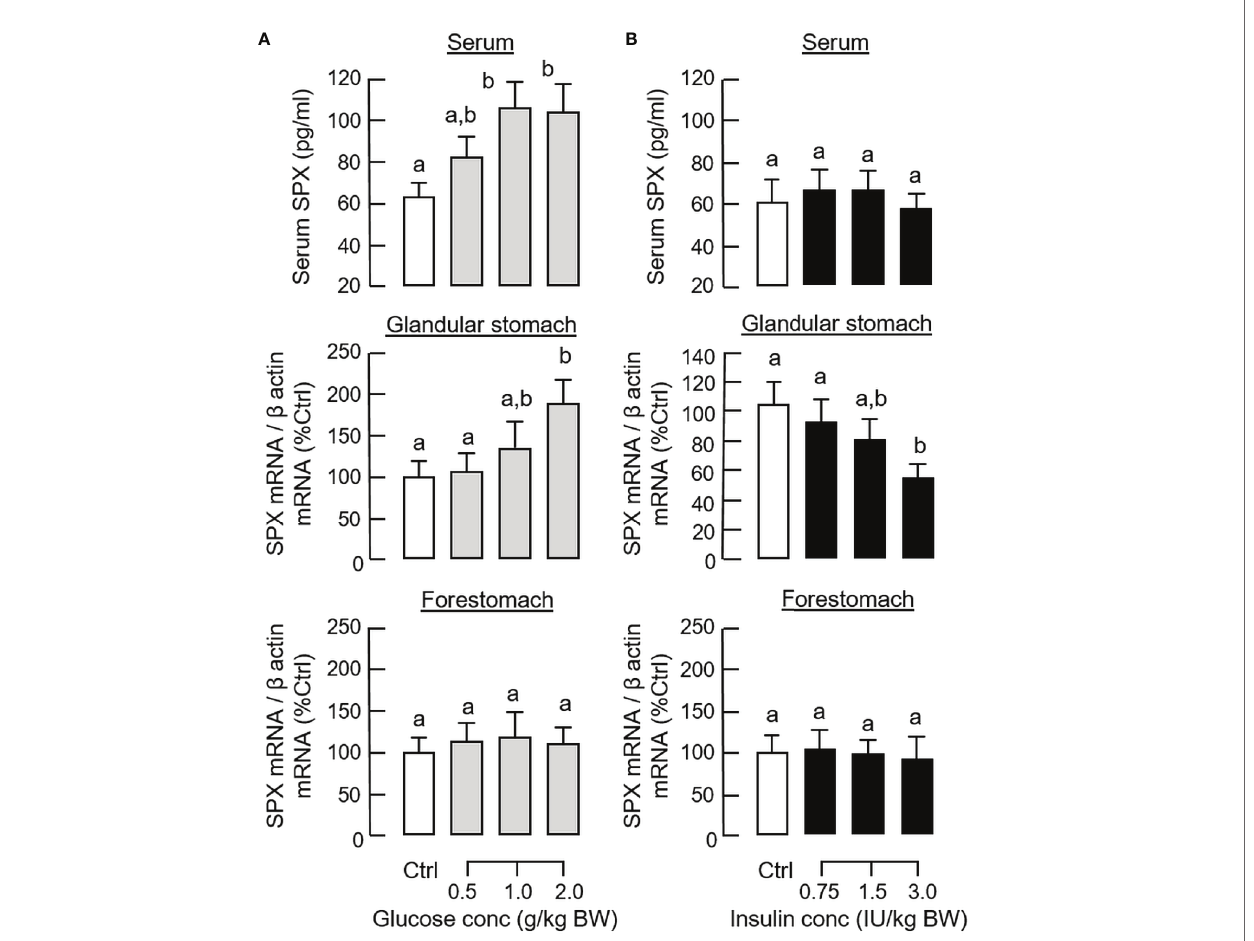
FIGURE 2 | Dose dependence of glucose and insulin treatment on SPX level in circulation and SPX transcript expression in glandular stomach of the mice. IP injection with increasing levels of glucose (A) or insulin (B) was performed in the mice (with saline injection as control treatment) and blood samples and different parts of the stomach were harvested at 1 h after drug treatment. Serum SPX levels were monitored using SPX ELISA and SPX mRNA expression in the glandular stomach and forestomach was quanti fi ed by real-time PCR for SPX transcript. For data normalization, b actin mRNA was used as the internal control and the normalized data were transformed as a percentage of the mean value in the control group (as “ %Ctrl ” ). Data presented (mean ± SEM, N = 10) were analyzed with one-way ANOVA followed by Newman-Keuls test. Groups denoted by different letters represent a signi fi cant difference at p <